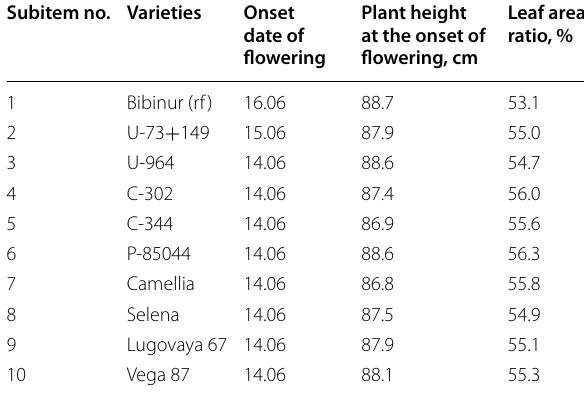
Table 1 Biometric indicators of alfalfa varieties Subitem no. Varieties